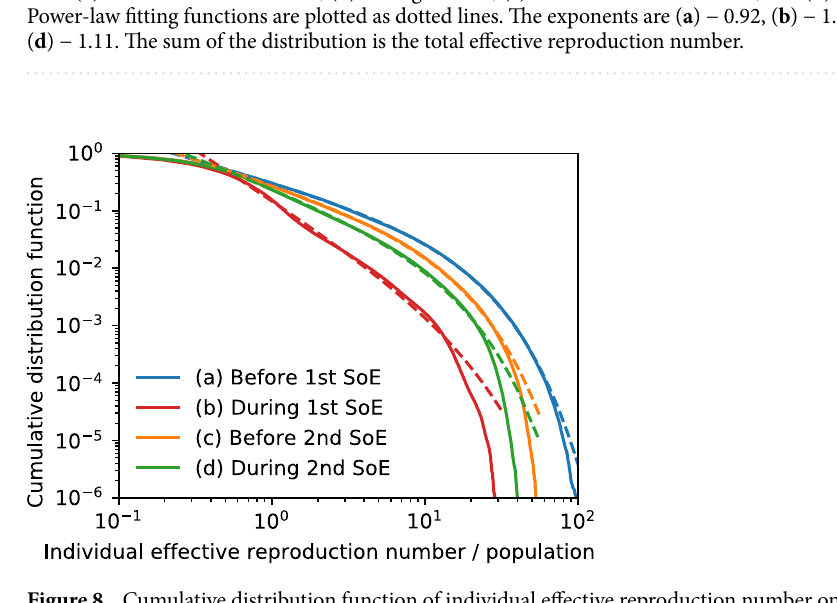
( i ) e is denoted by r . The mean of the